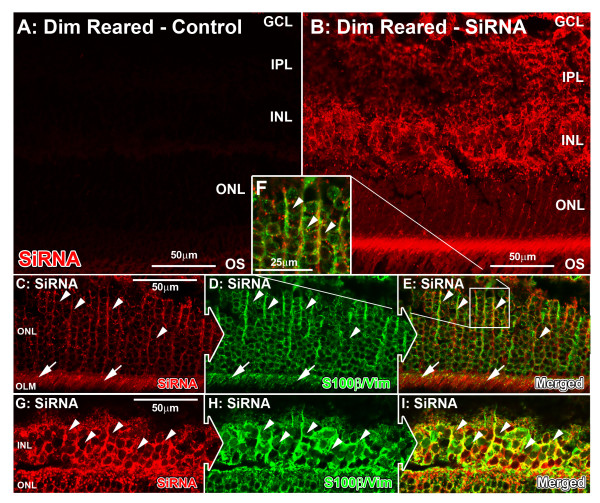
Localization of fluorescently-tagged small interfering (si)RNA following intravitreal injection in control retinas. (A) Fluorescence was not detected in retinas injected with Invivofectamine only in mice reared in dim light. (B) Strong fluorescence for injected siRNA (red) was seen after 24 hours of incubation, which was apparent throughout all cellular layers through to the outer nuclear layer (ONL). (C-I) Dual immunolabeling of siRNA (red) and the Müller-cell-specific proteins S100β/vimentin (green) showed colocalization of siRNA with S100β/vimentin in Müller cell processes situated within the (C–F) ONL and outer limiting membrane (OLM) (arrows), and (G–I) the inner nuclear layer (INL) (arrows). GCL, ganglion cell layer; IPL, inner plexiform layer; OS, outer segments.